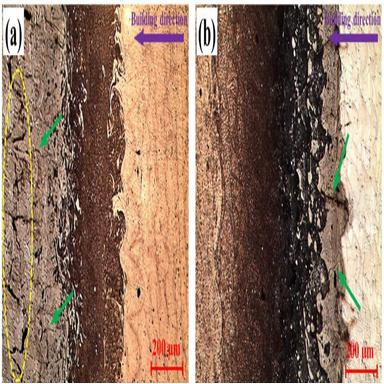
Cracks distribution at (a) the C/L interface and (b) the L/C interface.